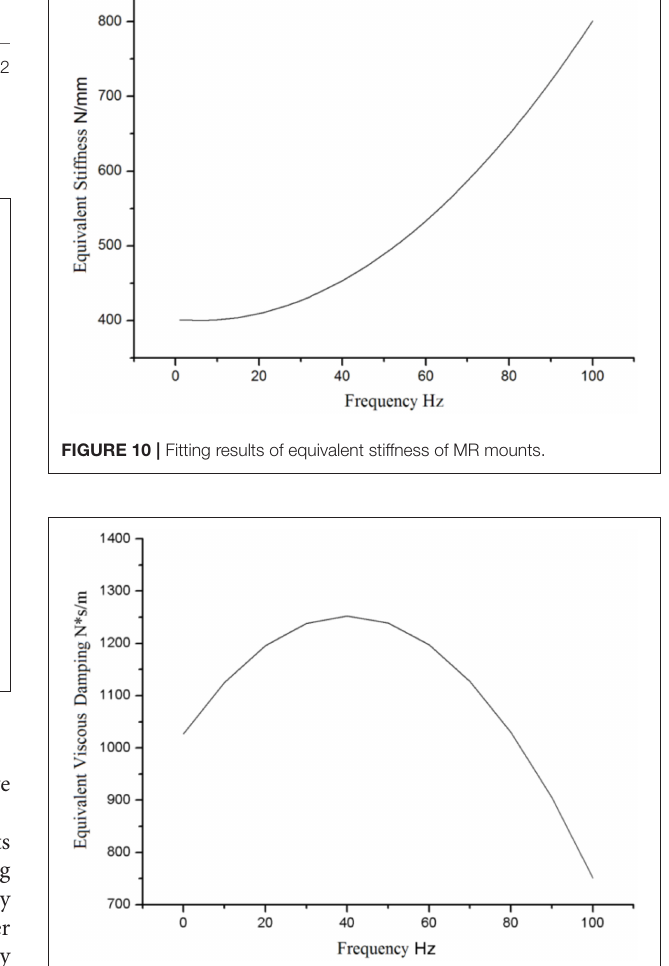
TABLE 2 | Identifying parameter results of MR fluid.